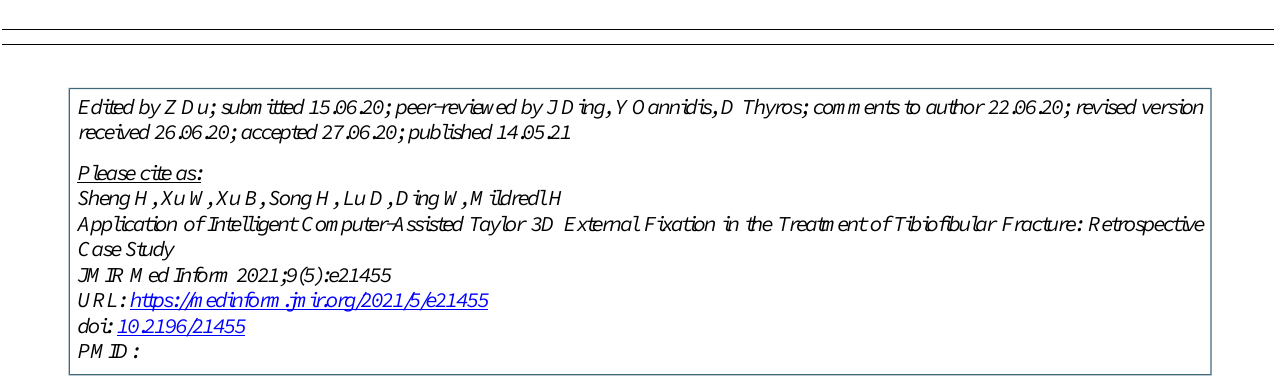
TSF: Taylor 3D external fixation VSD: vacuum sealing